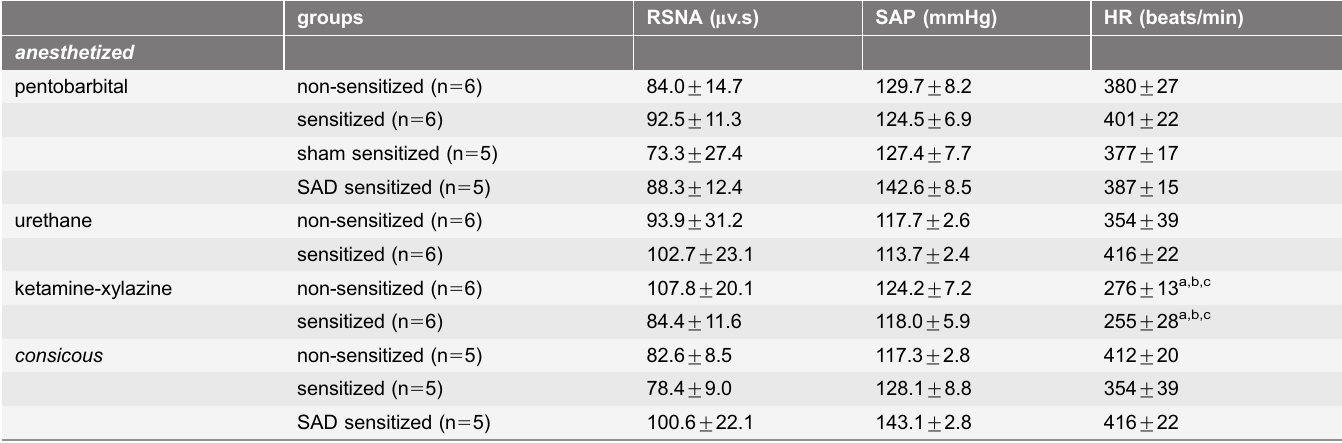
Table 1. The basal levels of the RSNA, SAP and HR before the antigen